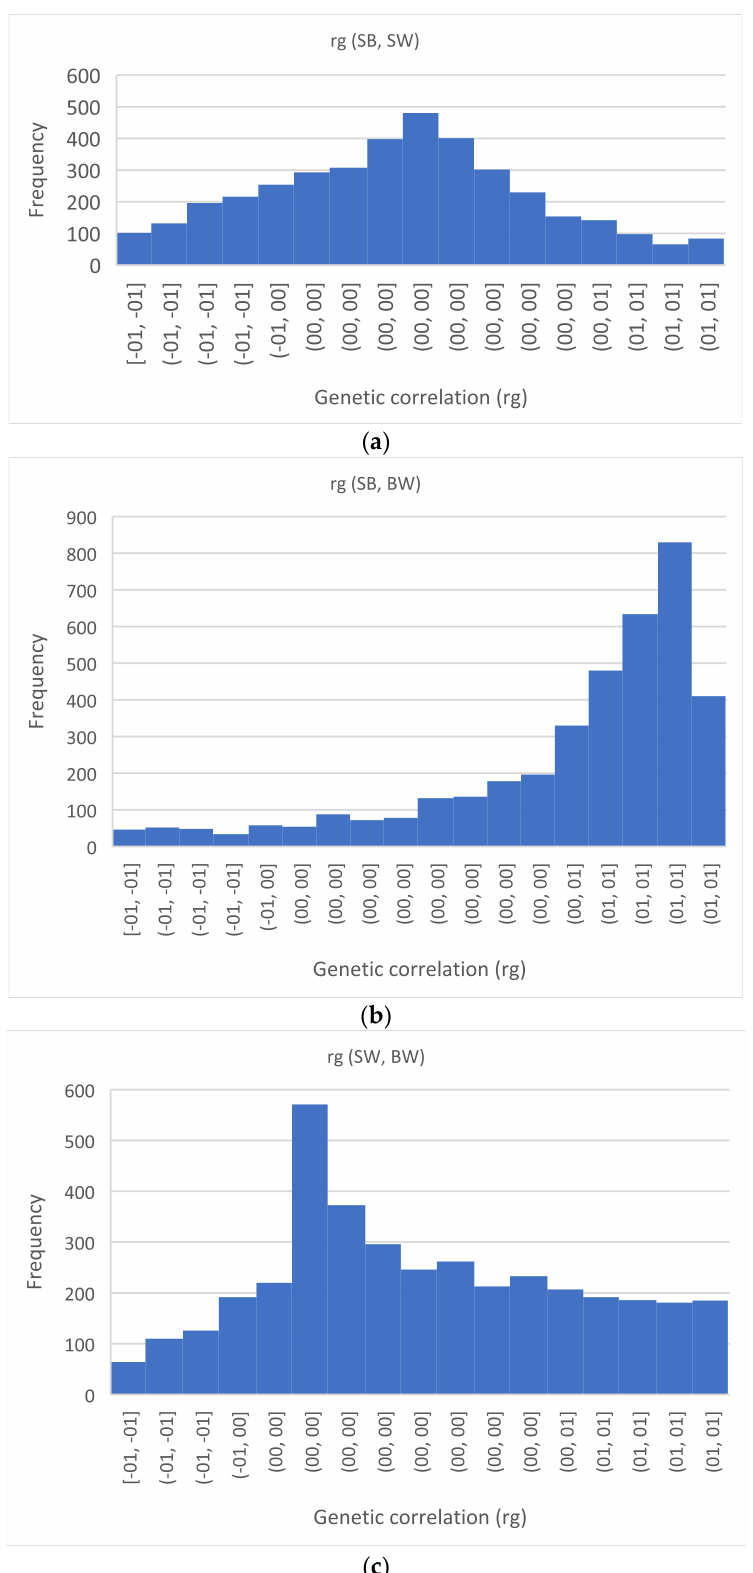
Figure 1. Marginal posterior distribution of genetic correlation (rg) between ( a ) survival at birth (SB) and weaning (SW), ( b ) survival at birth (SB) and individual birth weight (BW) and ( c ) survival at weaning (SW) and individual birth weight